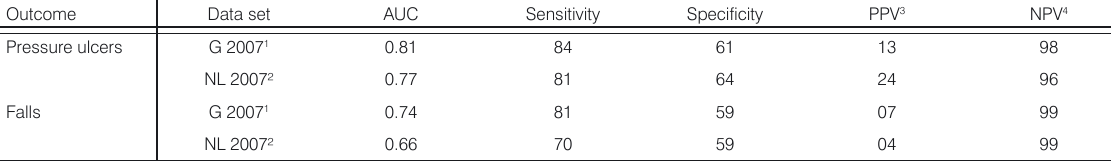
Table 4. Diagnostic accuracy of the CDS cut-off point 69 for pressure ulcers and